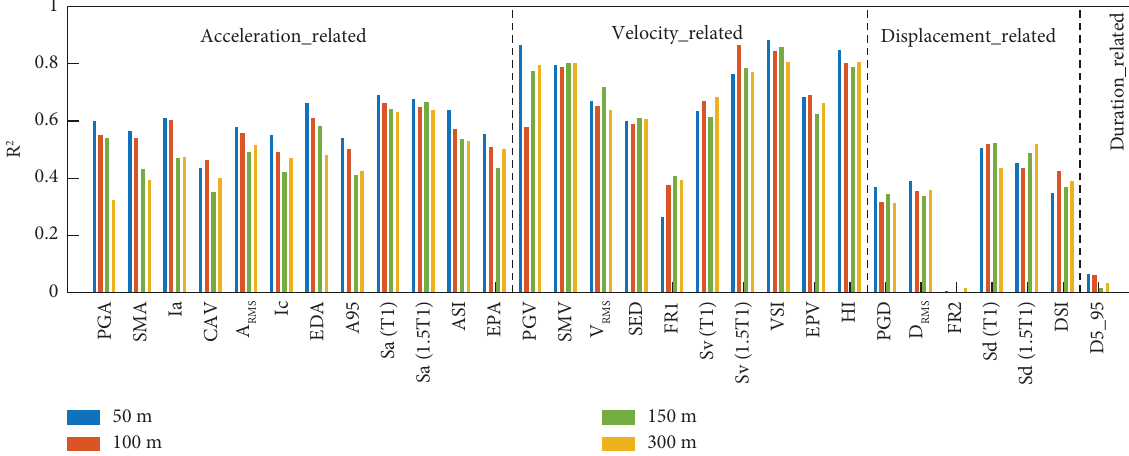
Figure 8: Correlation comparison of 29 candidate IMs against FOS for the slopes with diferent mining